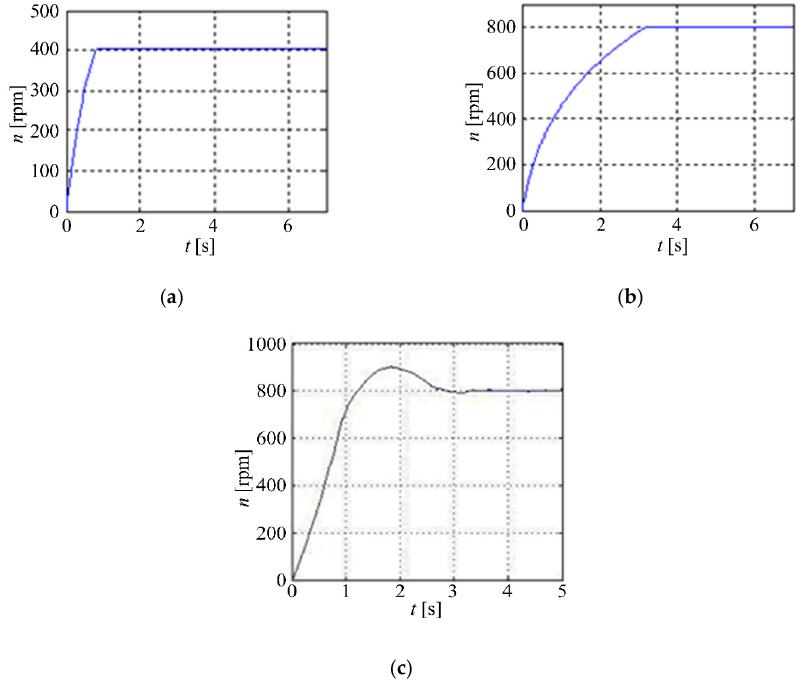
Figure 18. Simulated rotor speed curves: ( a ) the given rotor speed is n = 400 rpm, and the load is T = 0.05 Nm; ( b ) n = 800 rpm and T = 0.05 Nm; ( c ) n = 800 rpm and T = 0.50 Nm.